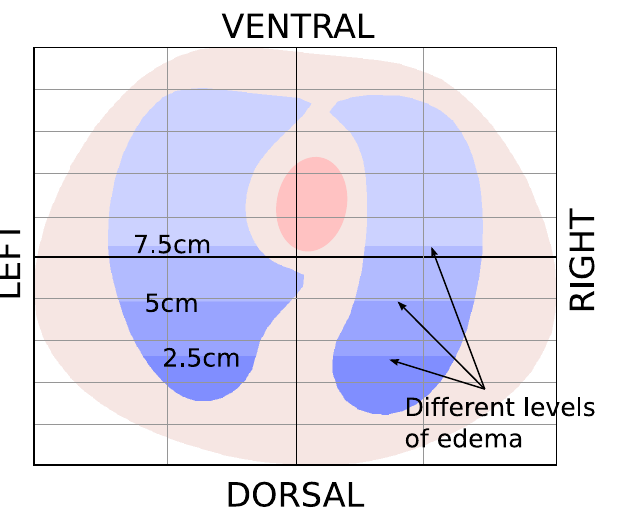
Fig.6: The transverse plane (i.e., imaging plane) of the chest model. The color contrasts of blue in the lung regions represent the levels of edetamous lung injury at 2.5 cm, 5 cm and 7.5 cm.